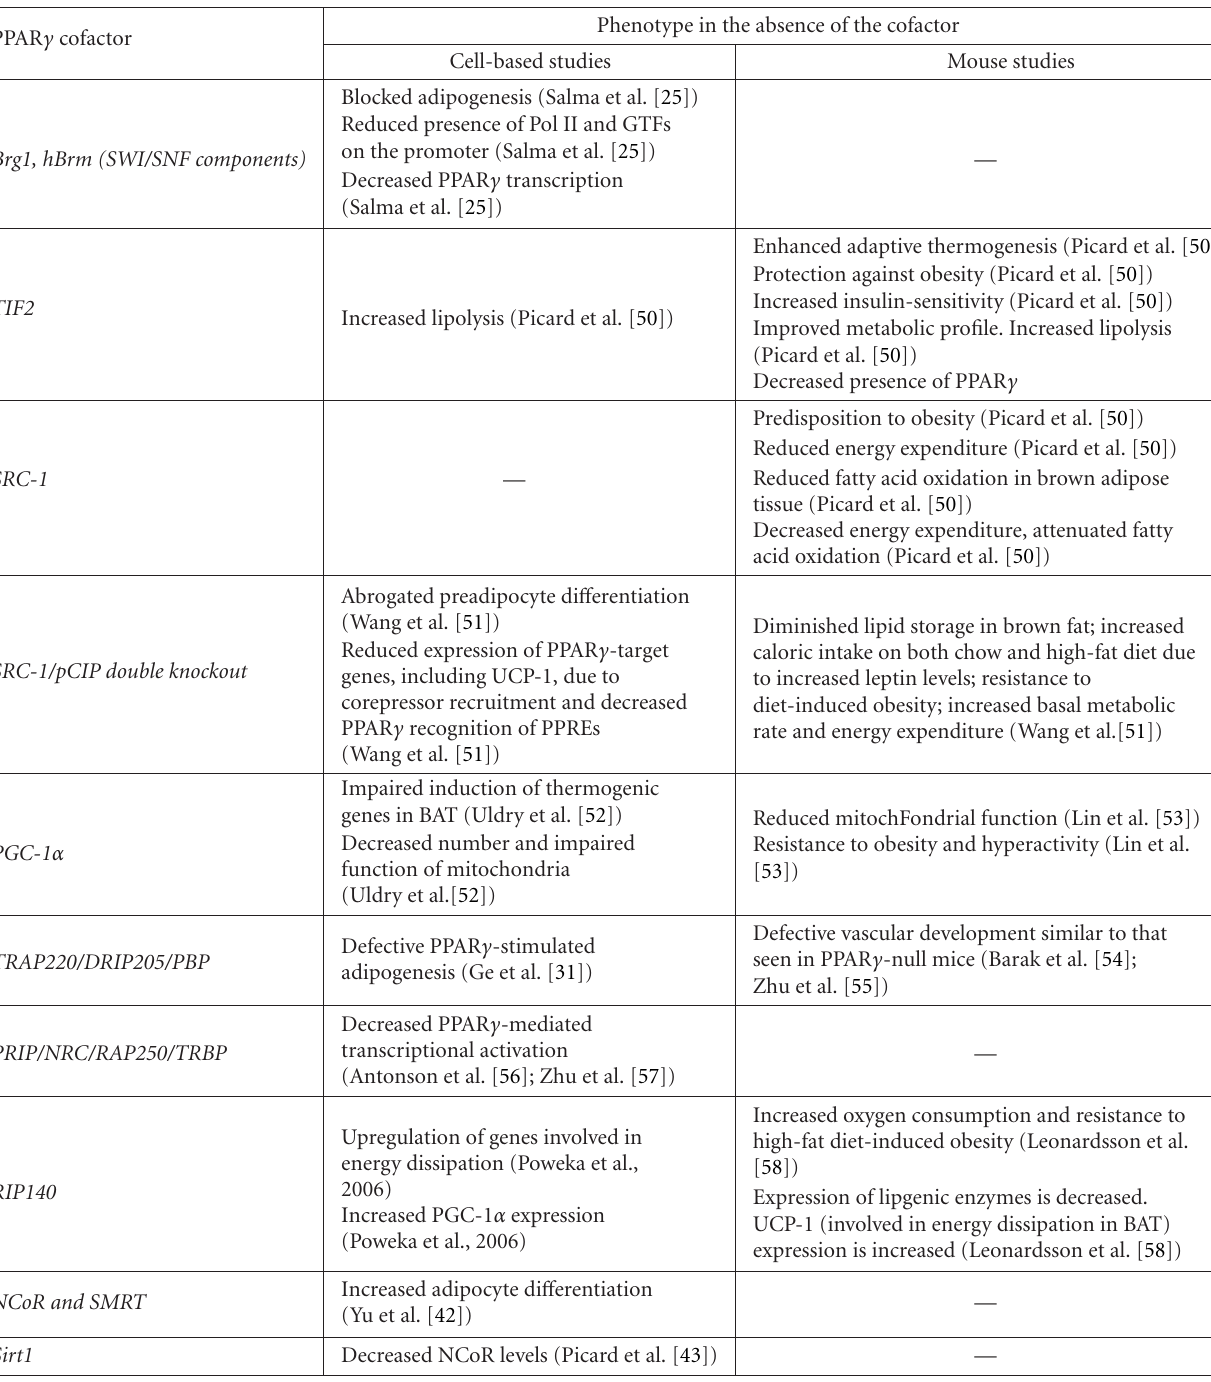
Table 1: Loss-of-function studies on PPAR γ cofactors in adipogenesis and energy